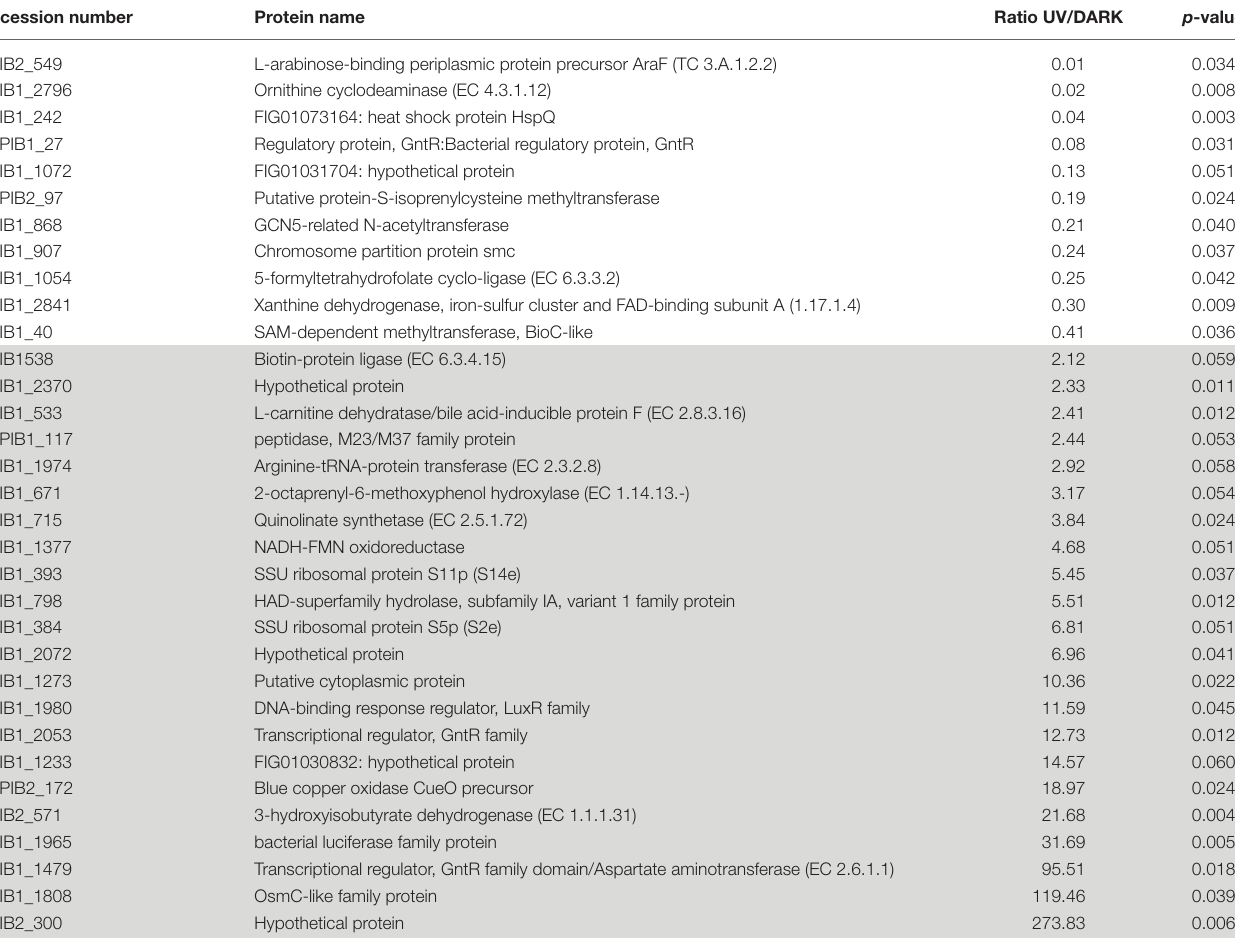
TABLE 3 | List of the quantified proteins differentially regulated between the UV stress and Dark control conditions (white: down-regulated proteins/gray: up-regulated proteins). Accession number Protein name